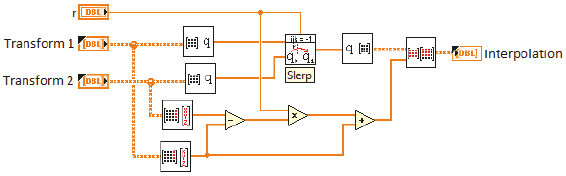
Figure 7: Interpolation implemented in LabVIEW .